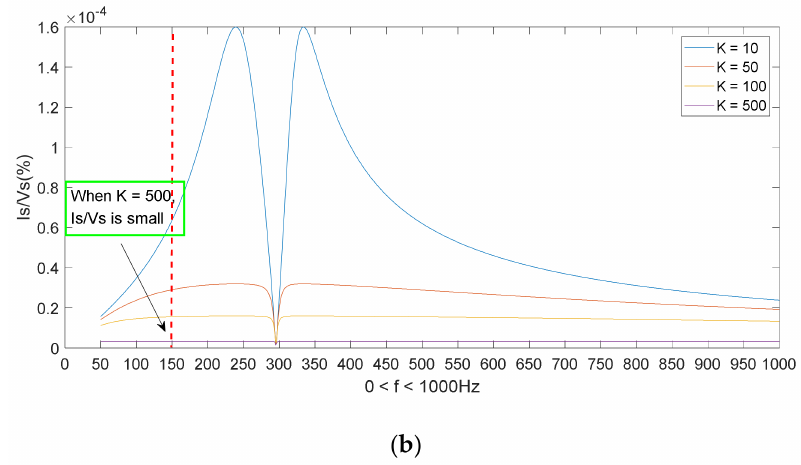
Figure 5. The sensitivity function values under a different K . ( a ) Considering the effect of the load- side harmonic current I Ln to the grid-side harmonic current I sn . ( b ) Considering the effect of the harmonic voltage V sn at the grid side to the grid-side harmonic current I sn